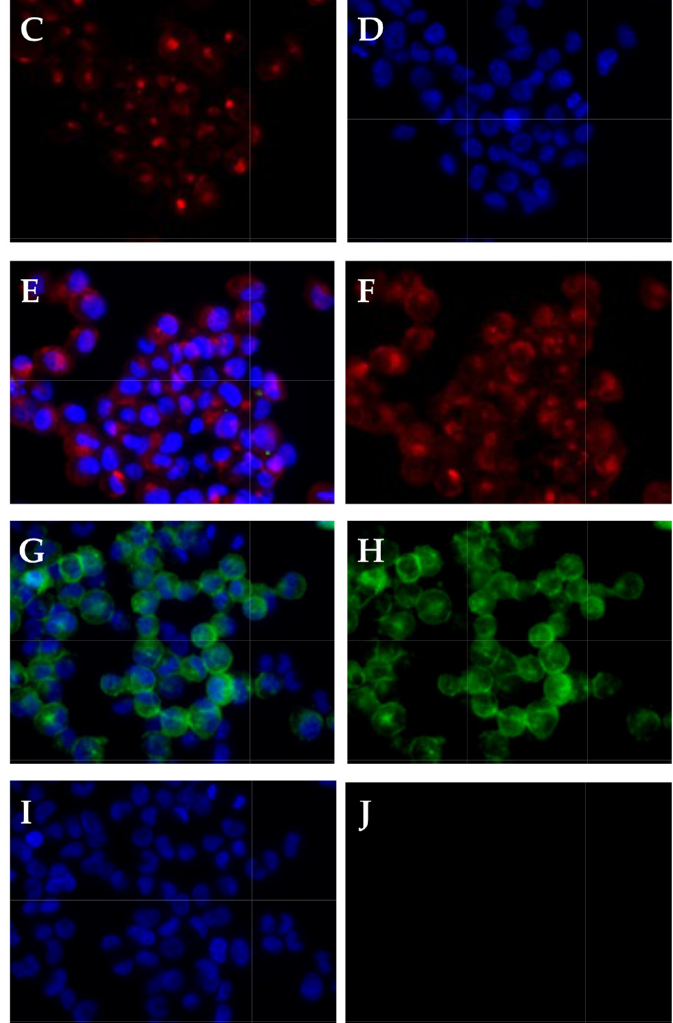
Figure 7. Detection of urothelial and mesenchymal lineage markers on UM-UC-13. ( A ) presents the merge of UM-UC-13 cells stained with antibodies reactive with ( B ) cytokeratin 5, ( C ) cytokeratin 8/18 and ( D ) counterstained by DAPI. ( E , F ) show staining of antibodies AE1/AE3 with or without DAPI. ( G , H ) show staining with anti-CD276 with or without DAPI, and ( I , J ) staining with anti-vimentin with or without DAPI.